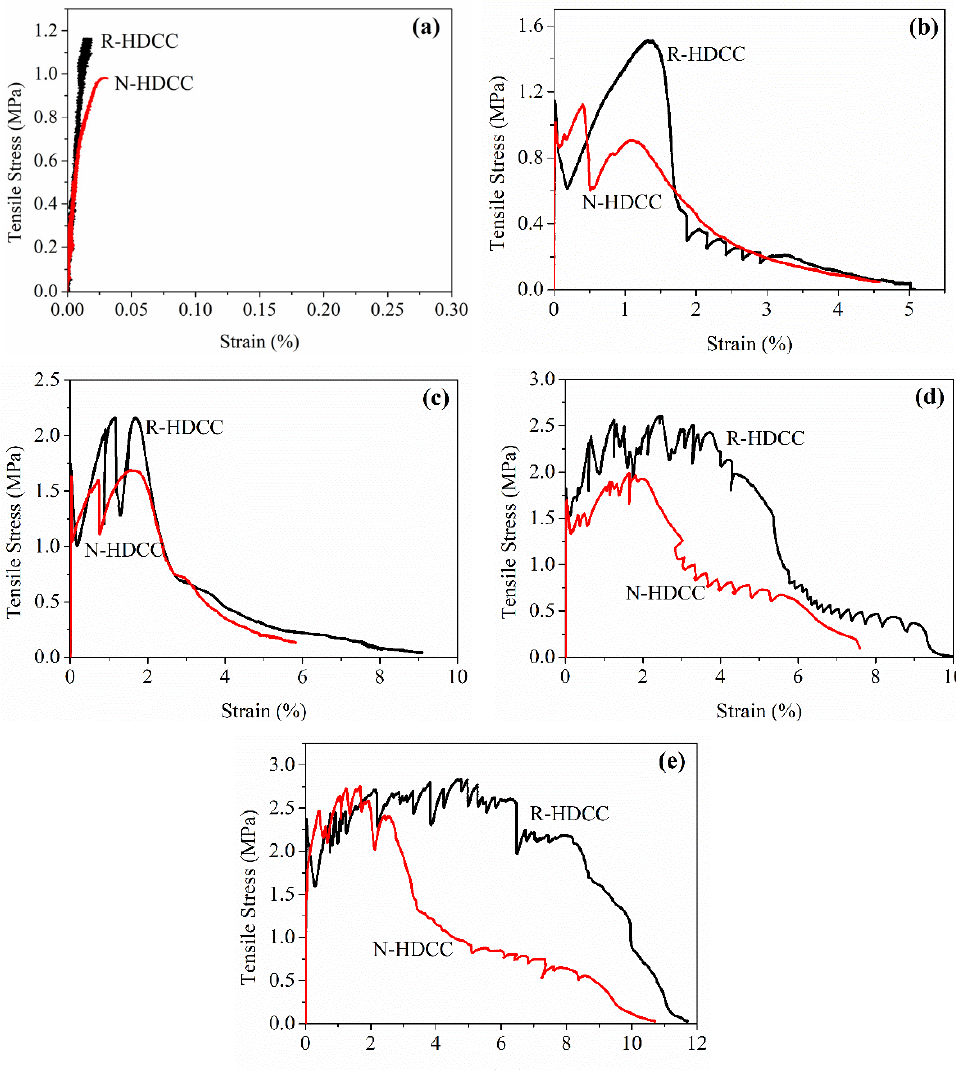
Figure 12. Stress versus strain of R-HDCC and N-HDCC: ( a ) V f = 0, ( b ) V f = 0.5%, ( c ) V f = 1.0%, ( d ) V f = 1.5% and ( e ) V f =